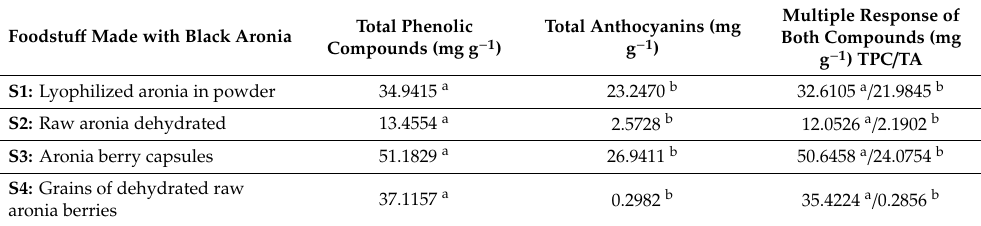
Table 5. Quantification of bioactive compounds (Total phenolic compounds and total anthocyanins) ( n = 3) in commercial samples of black aronia applying the optimal